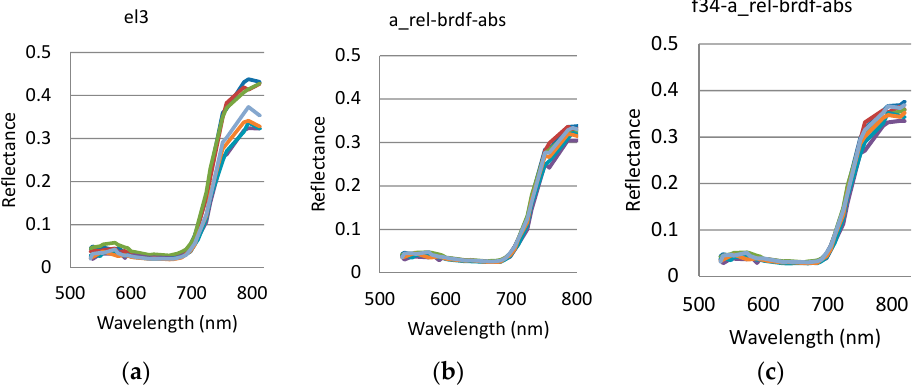
Figure 18. Impact of radiometric processing in spectral values on multiple overlapping images. Reflectance spectra of vegetation sample 21 was observed in seven overlapping images; individual lines plotted with different colors represent spectra taken from the images. The radiometric processing options were as follows: ( a ) Full dataset with empirical line based reflectance calibration and no BRDF correction; ( b ) the full dataset and ( c ) the dataset with flight f34 with BRDF and relative image-wise corrections and the reflectance calibration.